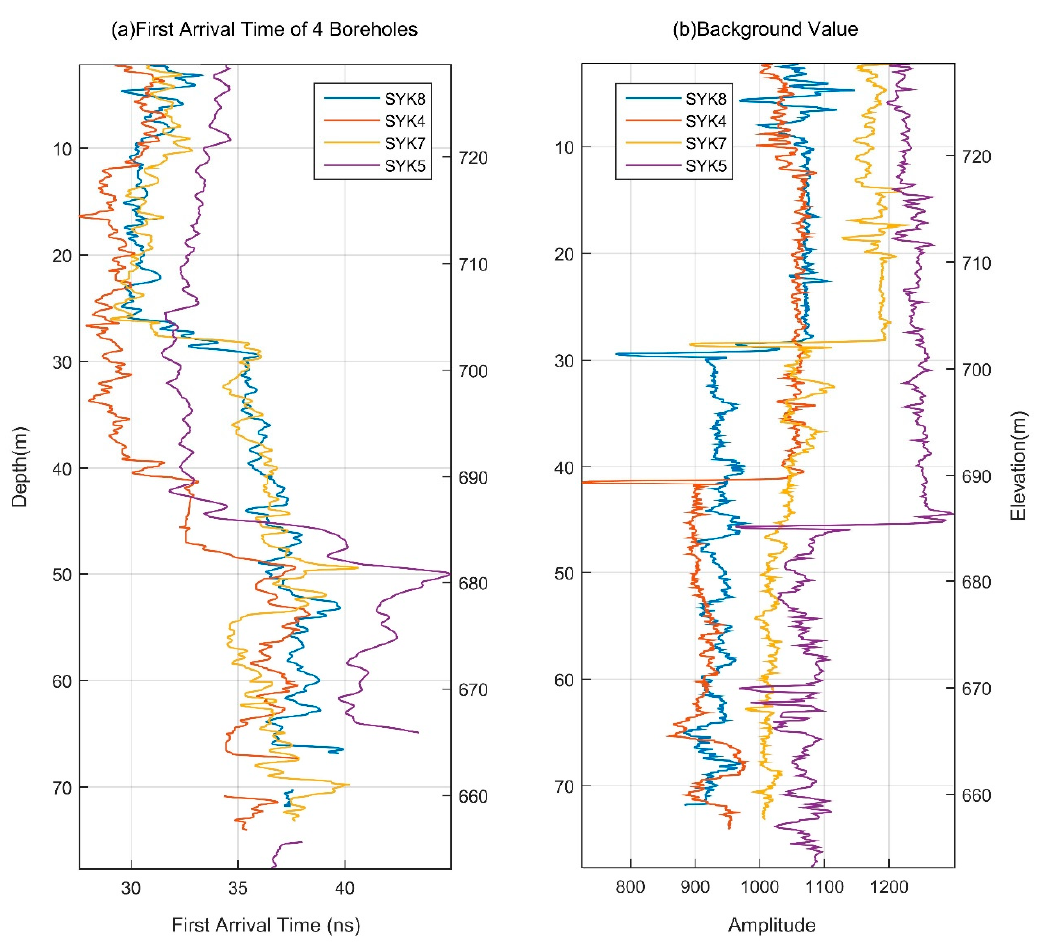
Figure 4. Calculated first arrival time ( a ) and the background values ( b